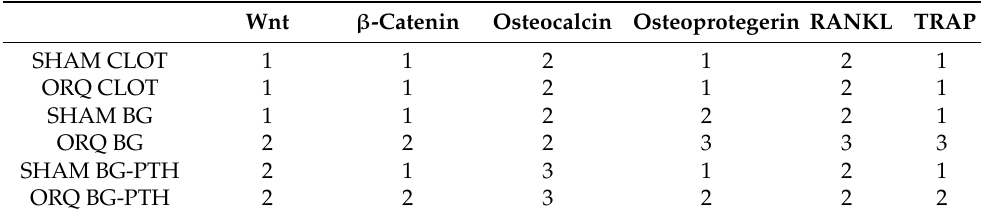
Table 4. Scores observed in the marking of Wnt, β -Catenin, osteocalcin, osteoprotegerin, RANKL and TRAP for all SHAM and ORQ groups (CLOT, BG and BG-PTH). Wnt β -Catenin Osteocalcin Osteoprotegerin RANKL TRAP SHAM